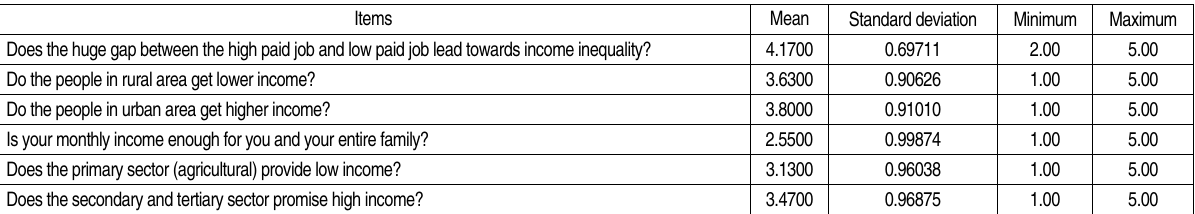
Table 5. Mean and standard deviation of income inequality